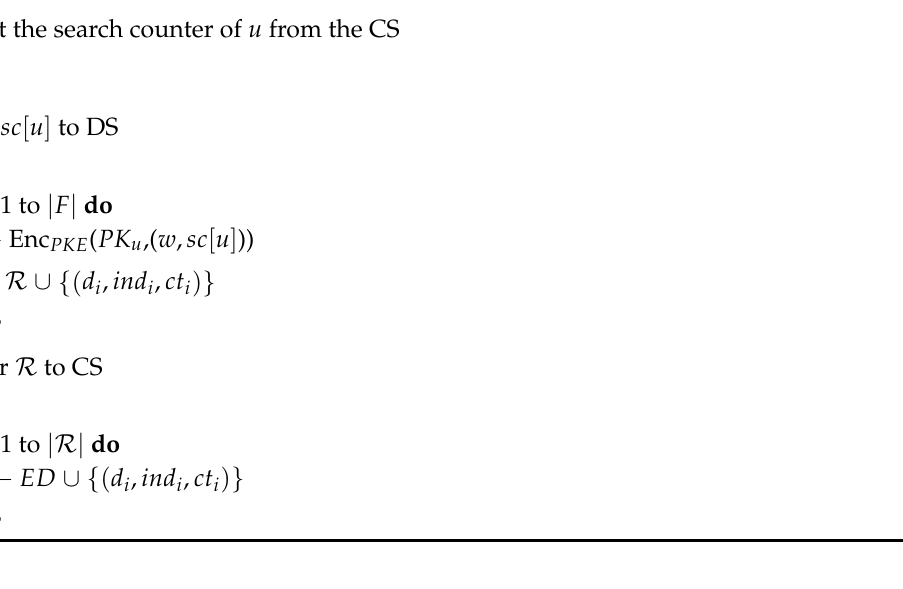
Algorithm 2: R ← PEKS ( PK u , w , u , F